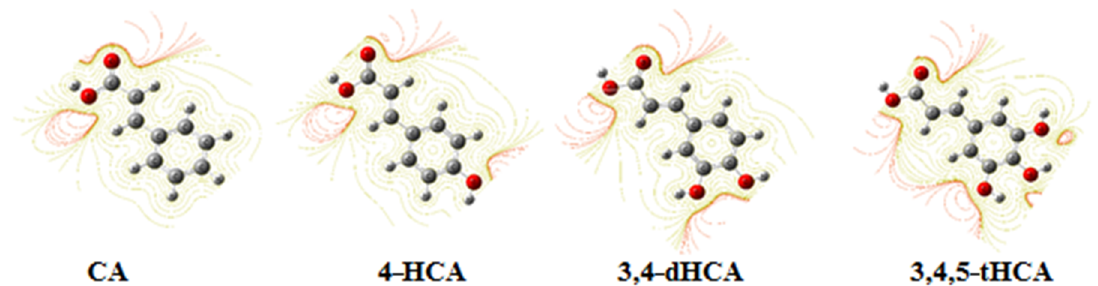
Figure 5. Density electronic charges (ESP) for CA; 4-HCA; 3,4-dHCA; and 3,4,5-tHCA acid calculated in CHelp/B3LYP/6- 311++G(d,p).